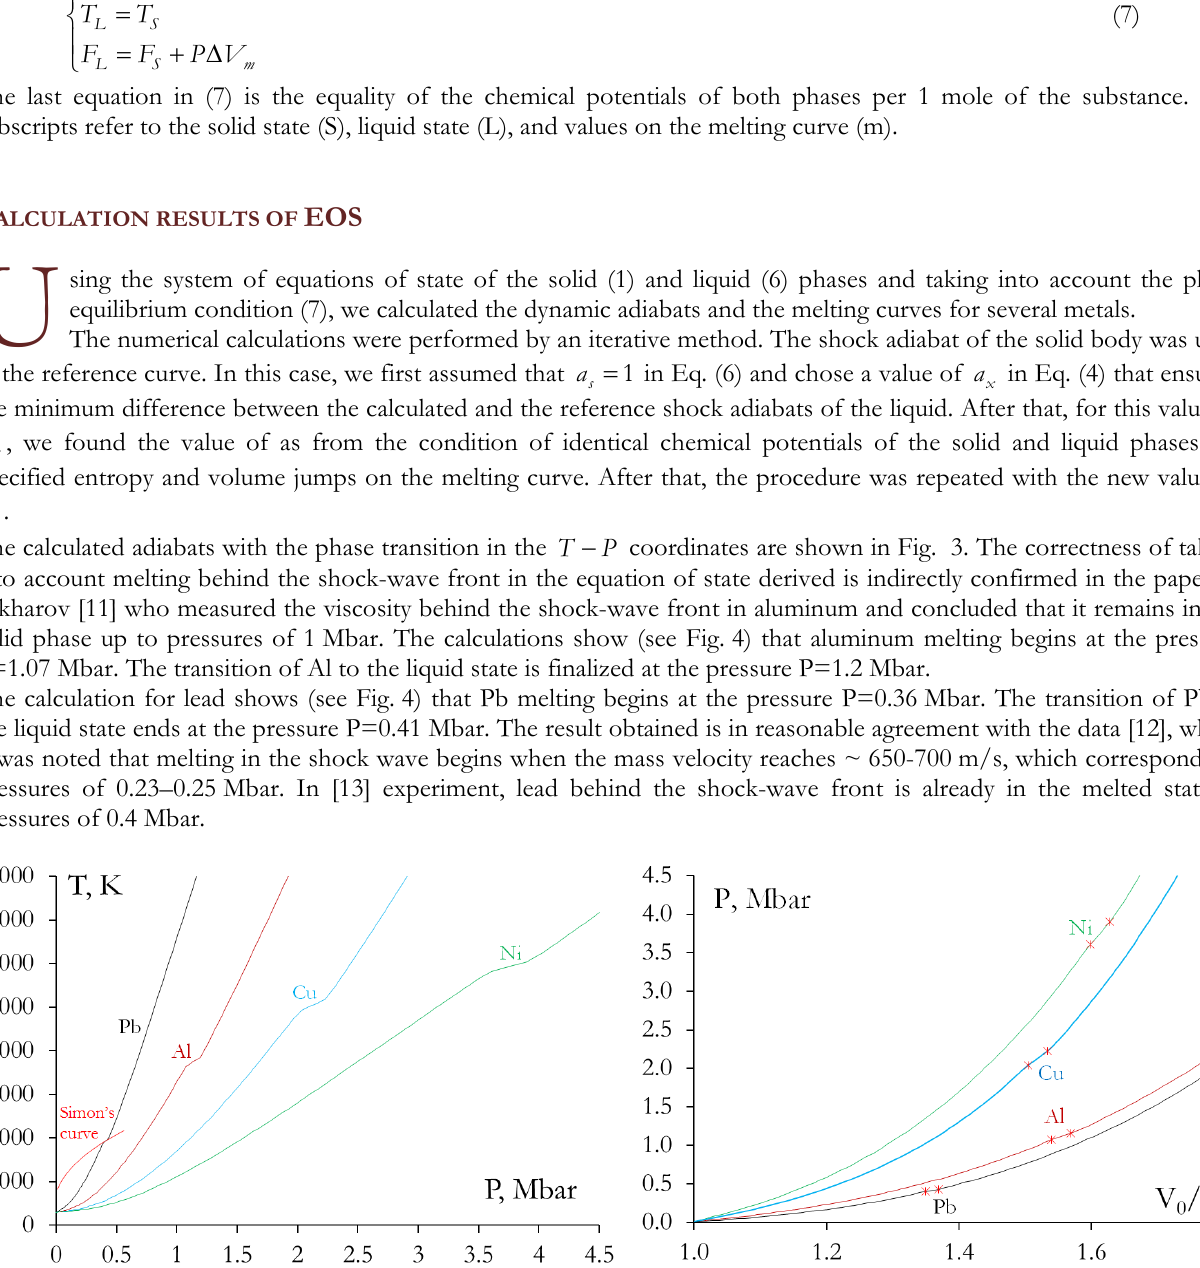
Figure 4: Shock adiabats of metals with allowance for melting. Figure 5: Shock adiabats of metals with allowance for